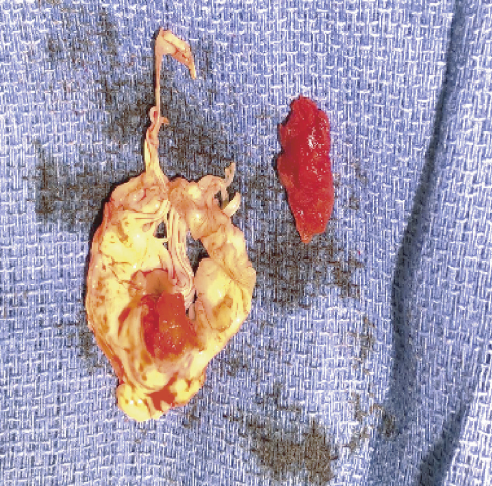
Figure 6: Gross specimen of the clot after the